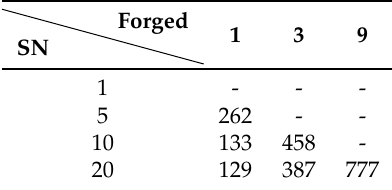
Table 4. Average time (in seconds) to blacklist forged nodes. Forged SN